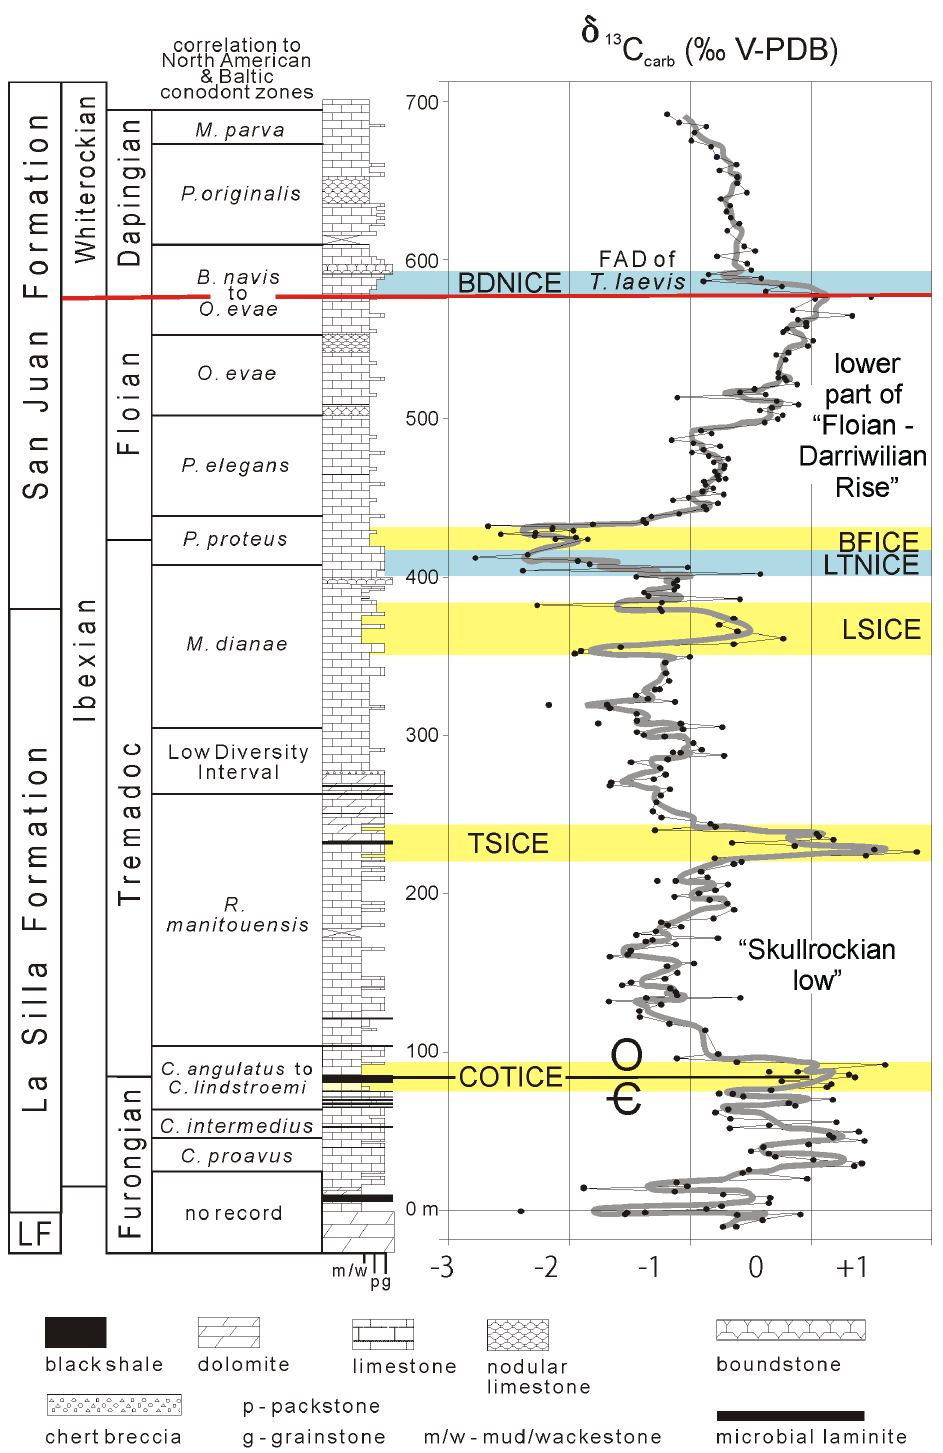
Fig. 2. Stratigraphic levels of δ 13 C events defined in this study (COTICE, TSICE, LSICE, LTNICE, BFICE, BDNICE) and plotted on a modified version of fig. 6 of Buggisch et al. (2003) showing the δ 13 C record in the Cerro La Silla section of the Argentine Precordillera (topmost La Flecha Formation through the upper San Juan Formation; late Furongian through Dapingian succession; LF (cid:150) La Flecha Formation). The FAD of T. laevis marks the base of the Middle Ordovician in the succession (Albanesi et al. 2006), indicating that the BDNICE starts just at the base of the